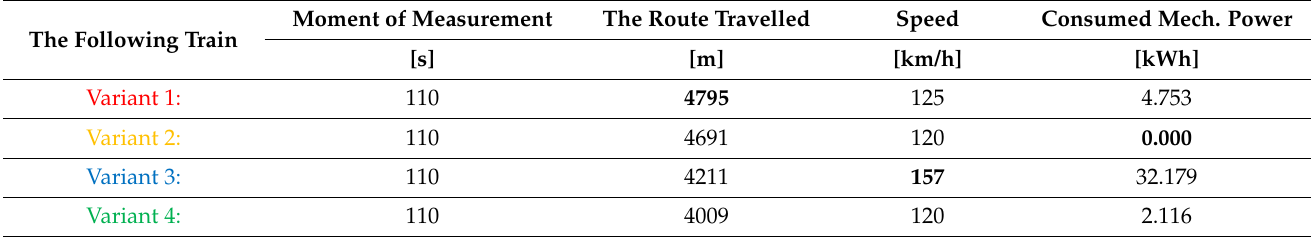
Table 6. Results for the variants of train P N according to context 3.